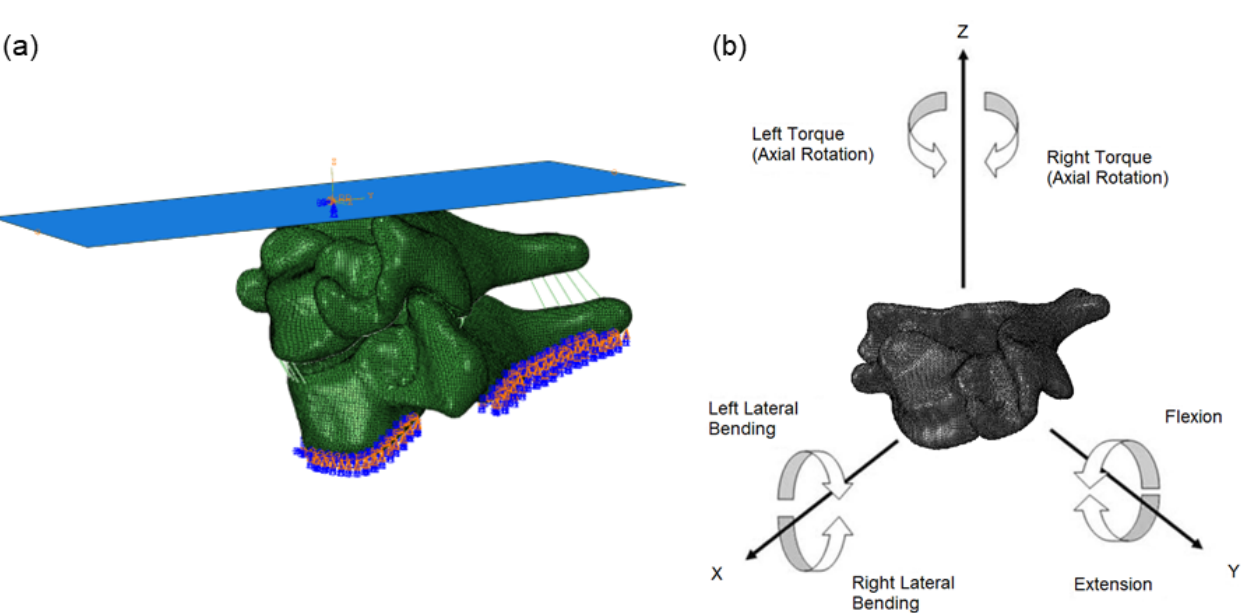
Figure 3. ( a ) Boundary conditions applied in the FSU model and ( b ) moments applied in the FEM.